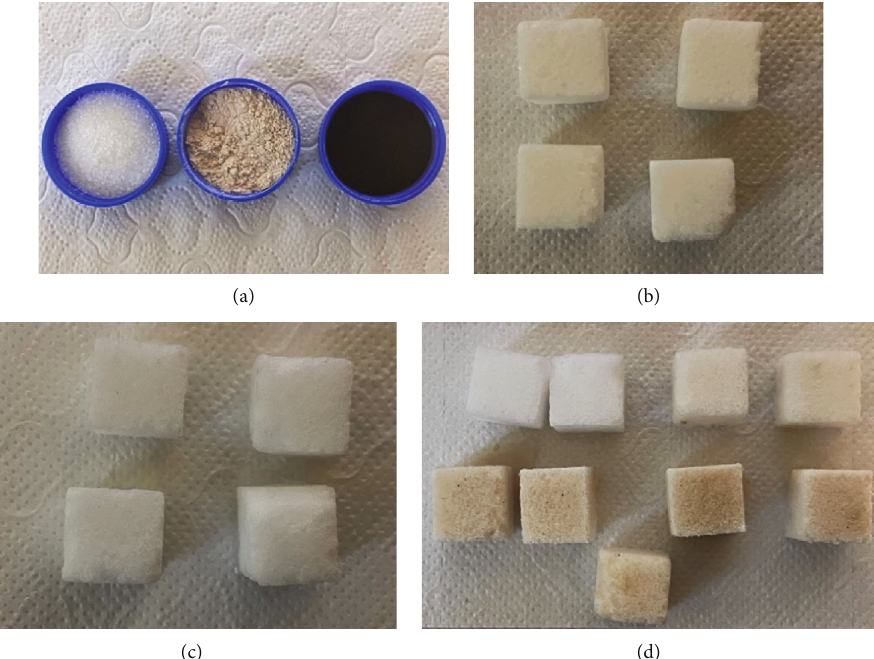
Figure 1: Images of (a) powders used in the preparation of L (left)-R (right): sugar, bentonite, and magnetite nanoparticles, (b) powdered sugar that has been kneaded into cubes, (c) porous PDMS structure, and (d) fabricated